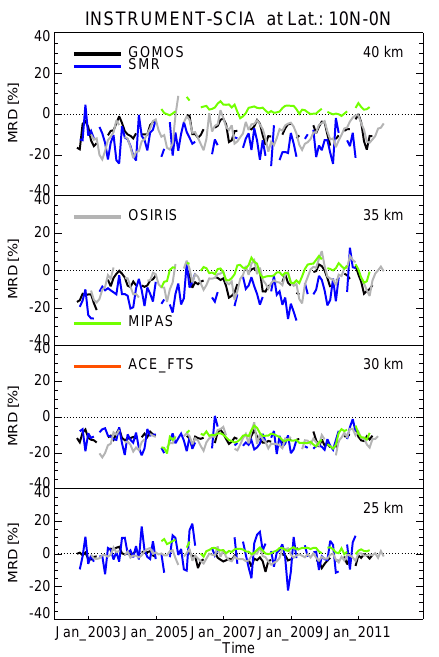
Figure 3. Same as Fig. 2, but for the tropical latitudes (10–0 ◦ N).